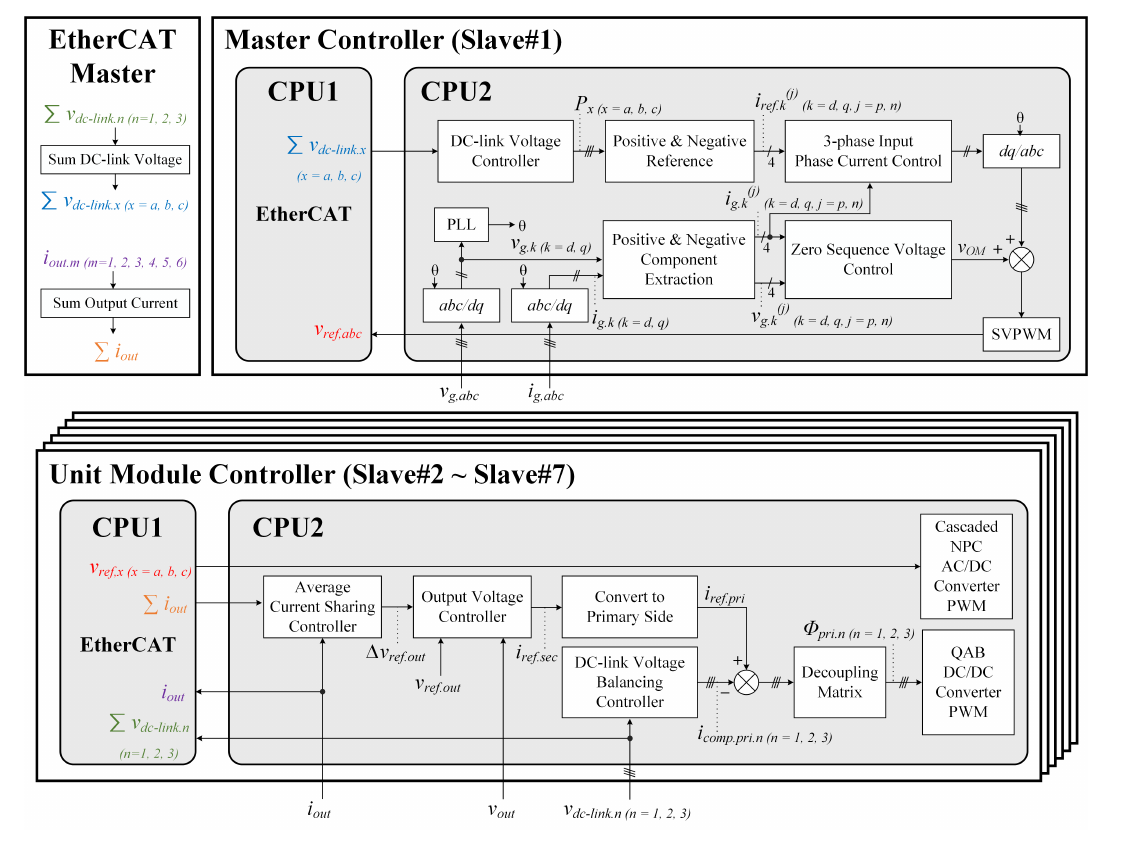
Figure 8. Control block diagram of the 13.2 kV class 3-phase solid state transformer